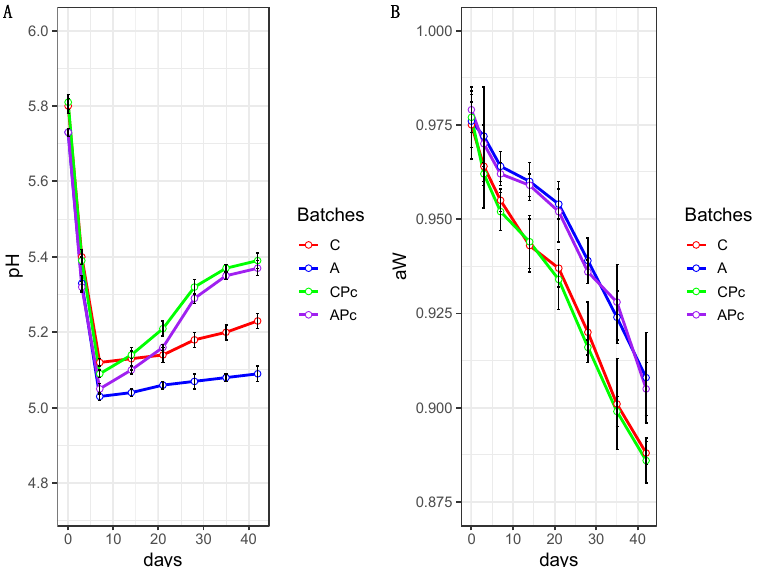
Figure 4. Line plots showing the behaviour of pH ( A ) and a w ( B ) in samples from batch C, conventional fermented sausage prepared with starter culture and 14% minced pork fat addition; batch A, prepared with 4% lemon albedo in total replacement of pork fat and starter culture addition; batch CPc, prepared with starter culture and 14% minced pork addition plus anti- Listeria Lactiplantibacillus plantarum Lpls100; batch APc, prepared with 4% lemon albedo in total replacement of pork fat and starter culture addition plus anti- Listeria Lactiplantibacillus plantarum Lpls100. The data are reported as mean values with error bars.